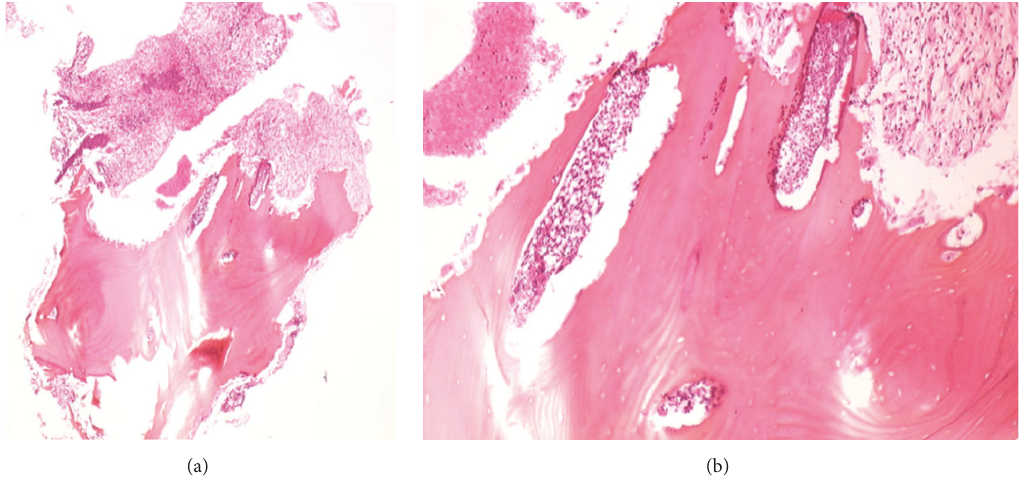
Figure 4: (a) Microscopic view of the bone biopsy. Hematoxylin-eosin staining (HES), low-magnification view ( × 10). Diffuse neutrophil infiltrate and osteoclastic bone resorption through neutrophil-osteoclast interactions. (b) HES, higher magnification ( × 40). Intense acute inflammation with numerous neutrophils and images of bone